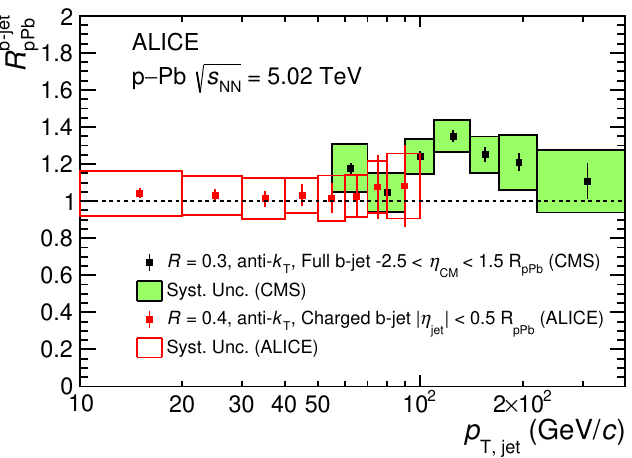
Figure 15. The nuclear modification factor R b-jet for charged-particle b jets measured by the pPb ALICE experiment, compared with the b-jet measurement from the CMS experiment [54]. The CMS measurement represents R = 0 . 3 fully reconstructed b jets within − 2 . 5 < η jet < 1 . 5 . There is an additional 22% scaling uncertainty from the PYTHIA pp reference on the CMS data that is not shown in the figure. The ALICE R b-jet data have an additional normalization uncertainty of 4 . 37% . pPb